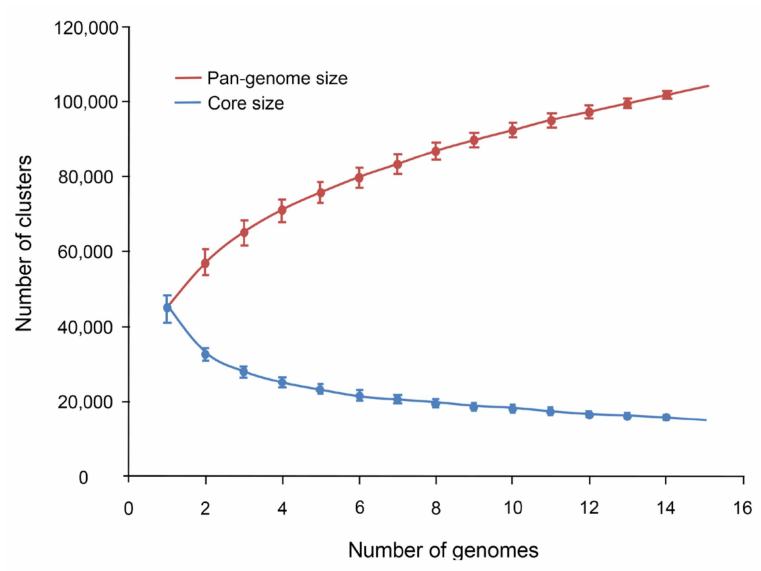
Figure 2. Simulation of pan- and core-genome sizes, in terms of number of orthologous gene clusters and pan-genome composition. X -axis is the number of genomes; the Y -axis is the number of clusters. The plot color legend is provided for each part.